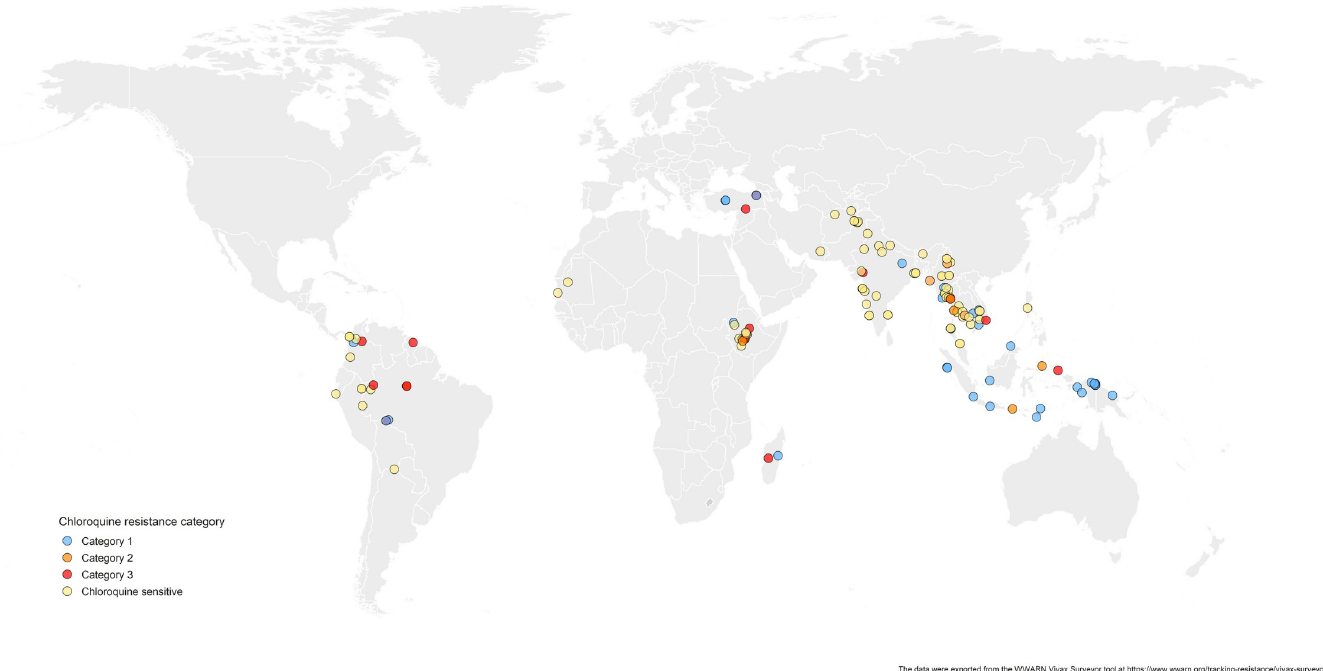
Fig 1. Levels of chloroquine resistance against Plasmodium vivax from 1985–2019. The data were exported from the WWARN Vivax Surveyor tool at https://www. wwarn.org/tracking-resistance/vivax-surveyor. Evidence for chloroquine resistance comes from P . vivax clinical trials published from 1985–2019. Some trials are from different years in the same area; this figure does not specify the change in chloroquine resistance pattern over time. CQS : Chloroquine sensitive, Category 1: very suggestive of resistance, Category 2: suggestive of resistance, Category 3 : potential evidence of resistance.